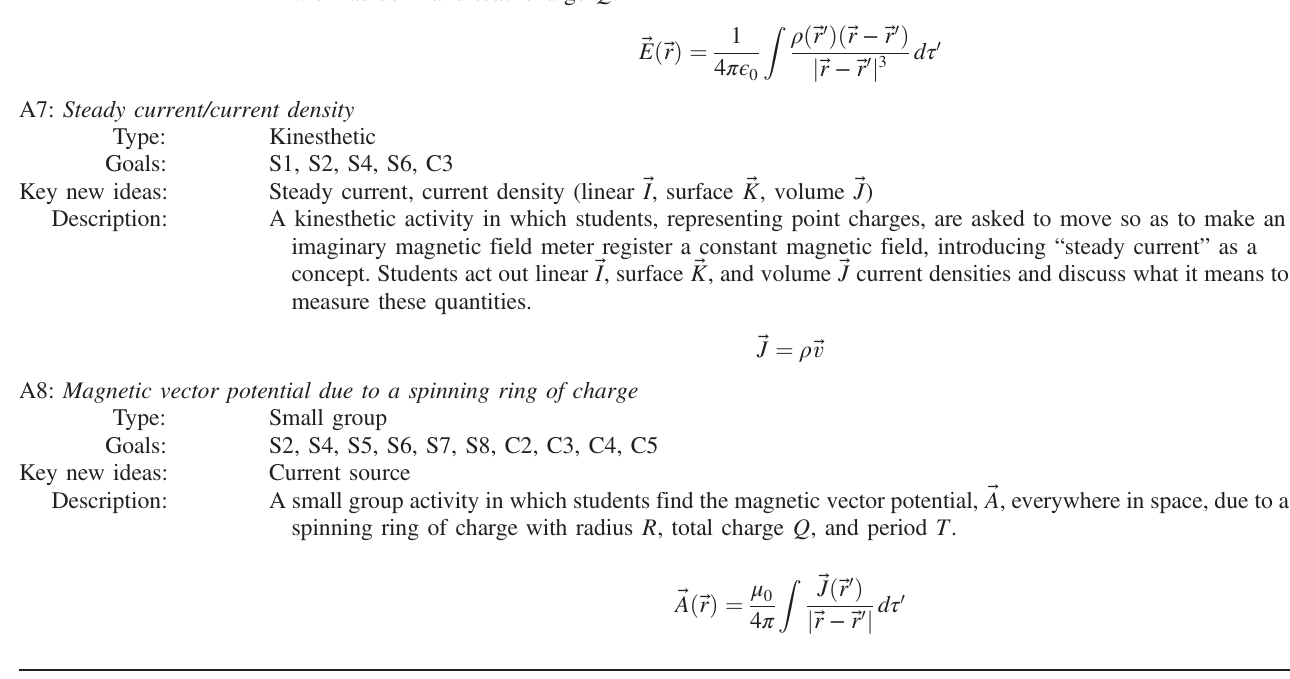
A6: Electric field due to a ring of charge Type: Small group Goals: Vector in numerator, curvilinear basis vectors with radius R and total charge Q .